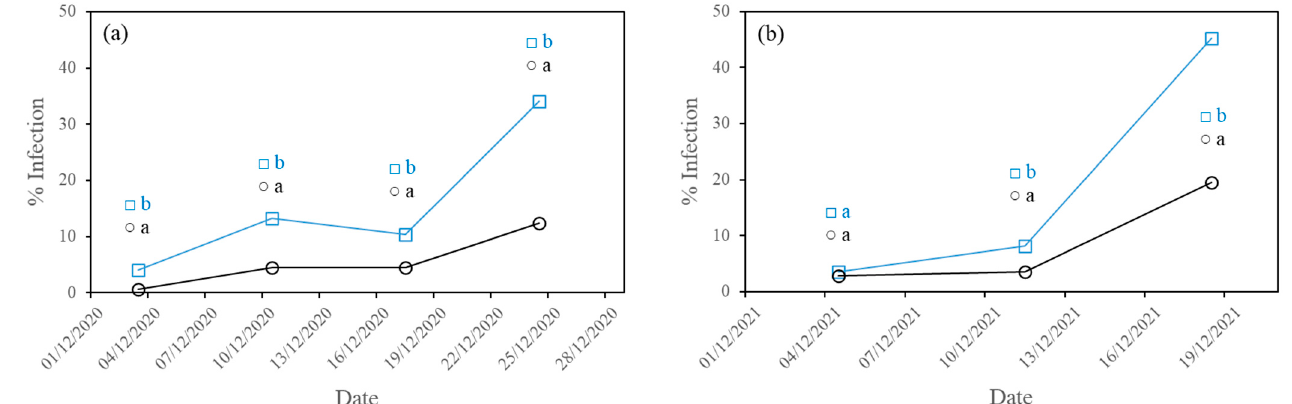
Figure 3. Development of powdery mildew ( S. fuliginea ) percentage of infection over time, for the first crop cycle ( a ) and for the second crop cycle ( b ). Sector with commercial film C F ( □ ); Sector with experimental film E F ( ○ ). Different letters indicate statistically significant difference ( p -value ≤ 0.95).